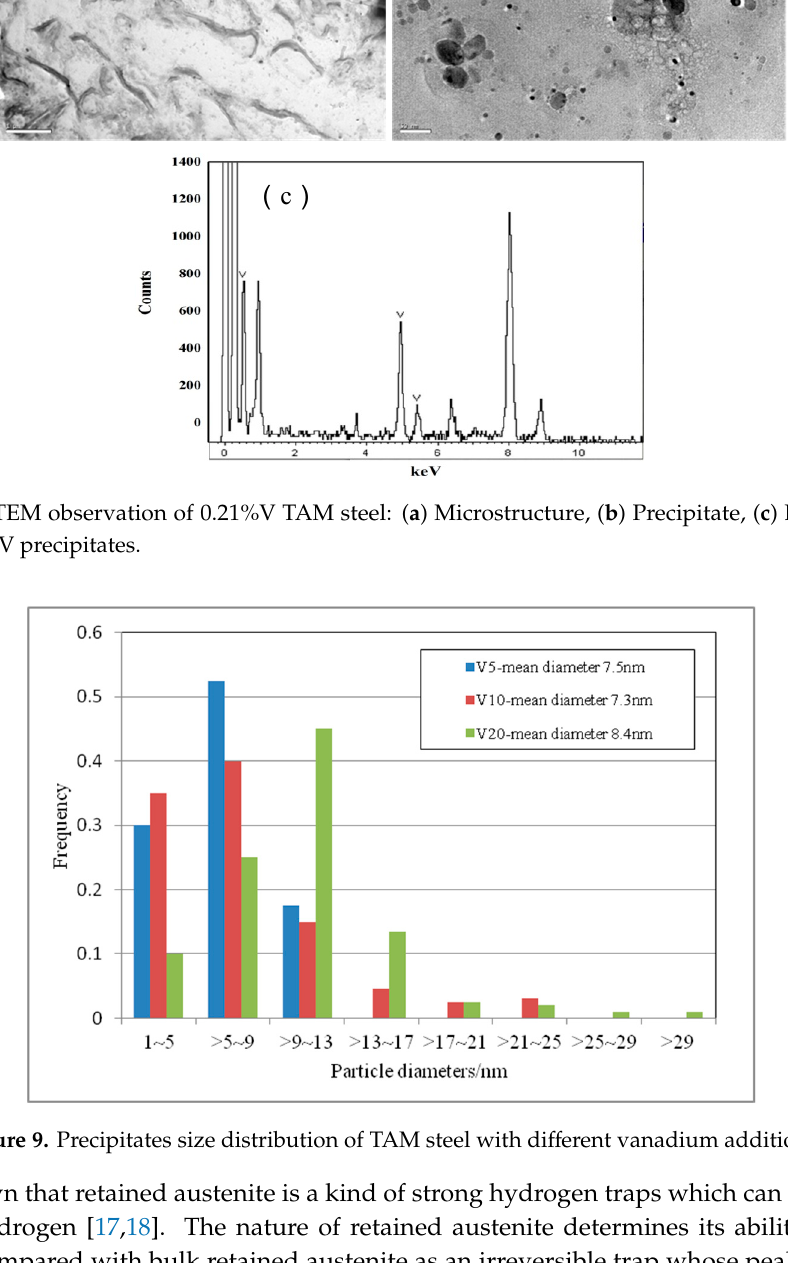
Figure 8. TEM observation of 0.21%V TAM steel: ( a ) Microstructure, ( b ) Precipitate, ( c ) EDS result indicating V precipitates.